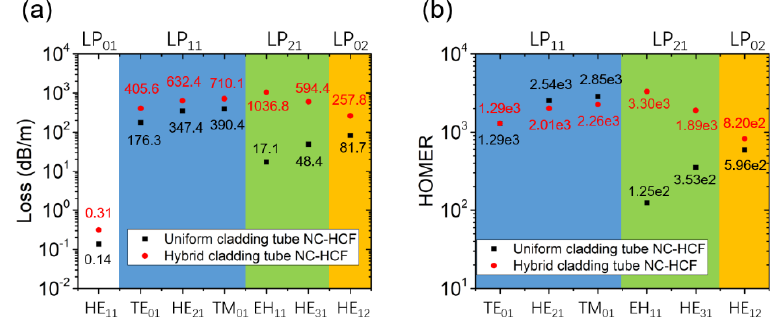
Figure 3. A comparison between the hybrid NC-HCF with D tubeA = 0.68 D core and D tubeB = 0.52 D core (red points) and the NC-HCF with uniform cladding tubes with D tube = 0.68 D core (black squares). ( a ) The confinement loss in units of dB/m and ( b ) the higher-order mode extinction ratio (HOMER).